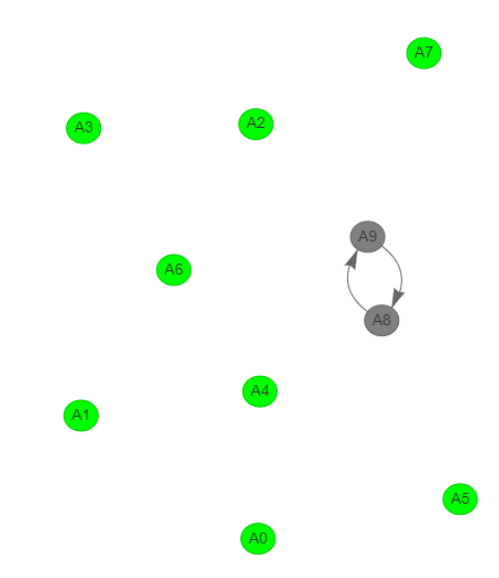
Figure 7. ASPIC+ argumentation graph.